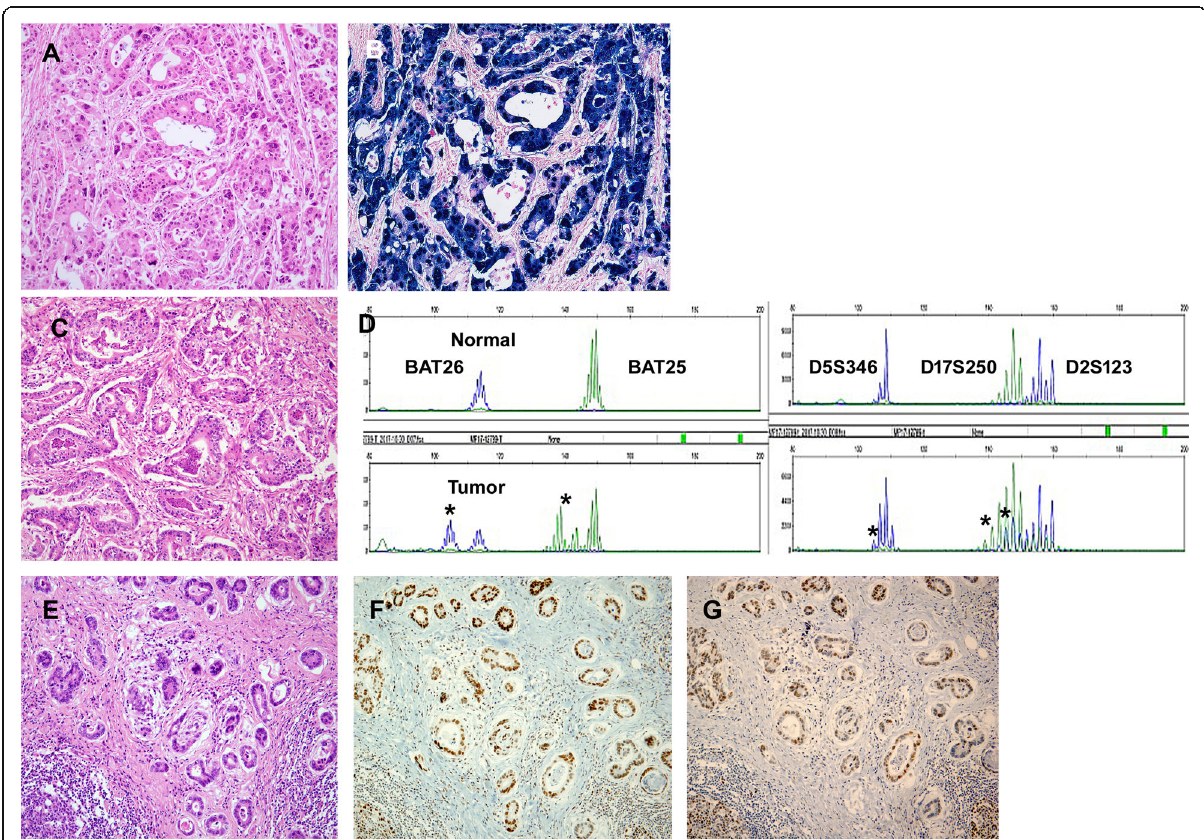
Fig. 3 Representative features of each molecular group. a , c , e Hematoxylin and eosin-stained images of each group. a - b Epstein-Barr virus (EBV)- positive gastric carcinoma; b Black signals are detected in most tumor cell nuclei by in situ hybridization for EBV-encoded small RNAs. c - d Microsatellite instability (MSI)-high gastric carcinoma; d Microsatellites are recognized for five markers (BAT26, BAT25, D5S346, D17S250, and D2S123) by multiplex PCR, and are indicated with asterisks (*). e - g Conventional carcinoma (EBV-negative and non-MSI-high); hMLH1 f and hMSH2 g were retained in tumor cell